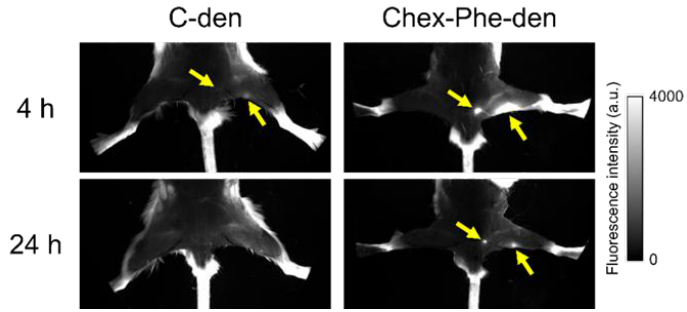
Figure 4. Fluorescence imaging of the lymph nodes after 4 h and 24 h. The arrows indicate the visualized lymph nodes.